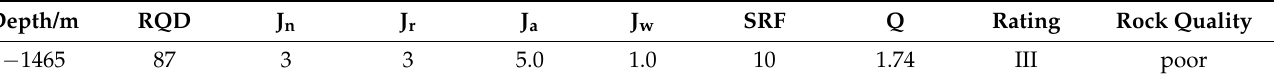
Table 2. Evaluation results of the Barton rock mass classification (Q).